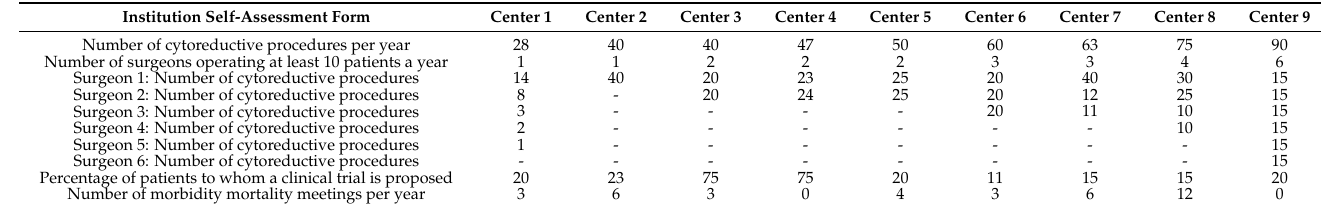
Table 1. Institution self-assessment